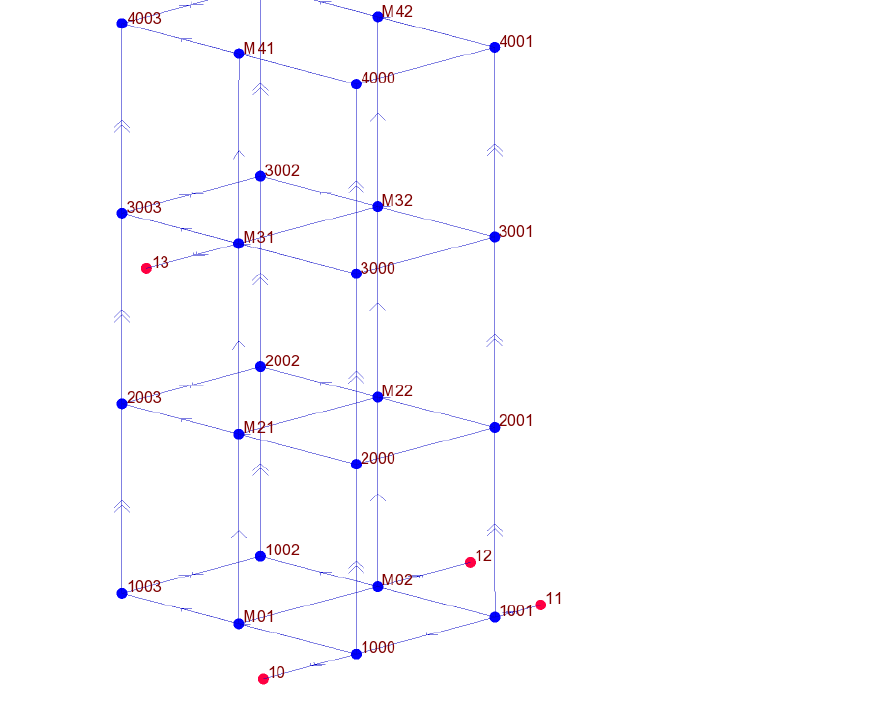
Figure 22. The test building geometry, sensor and target placement, and measurement directions.